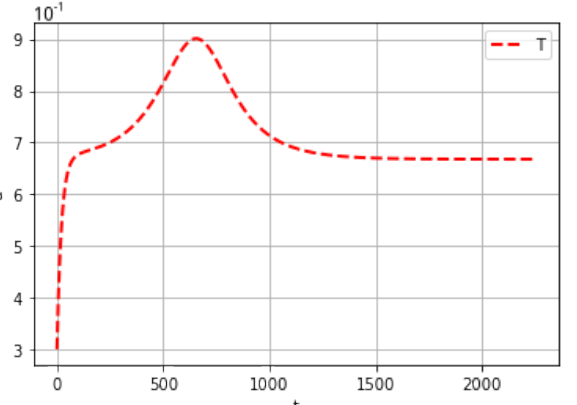
Figure 5. Dynamics of the anti-tumor CTL response. The x -axis is time in days. The y -axis is the relative number of cells on a scale of 10 4 .